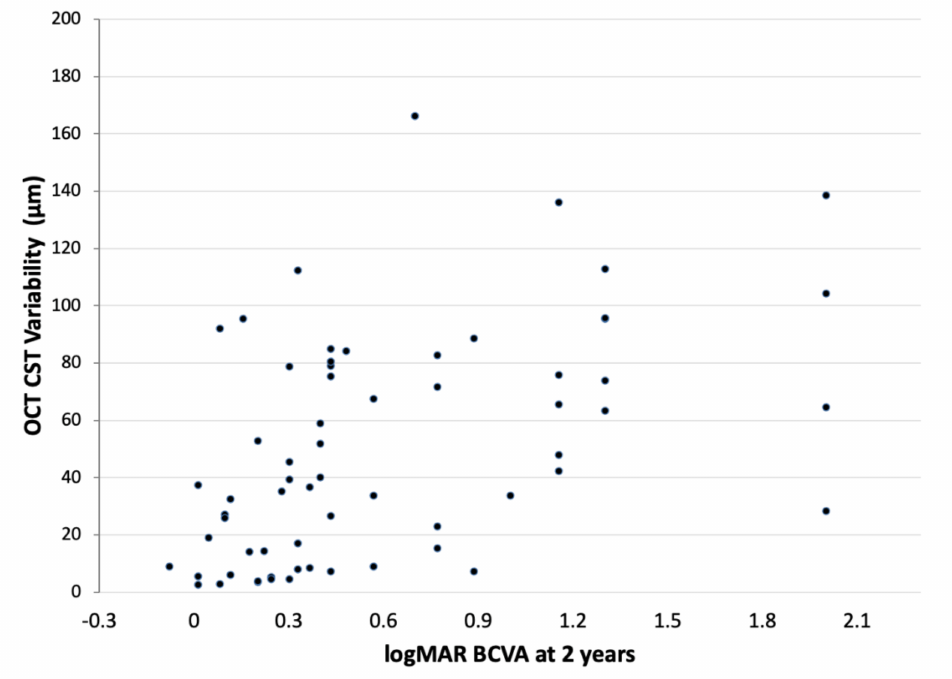
Figure 1. Correlation analysis between OCT CST variability and logMAR BCVA at 2